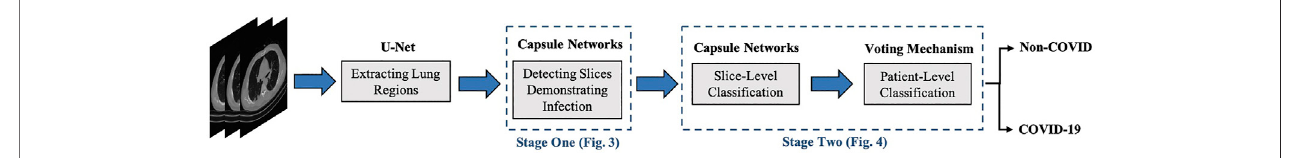
FIGURE 2 | The two-stage architecture of the proposed COVID-FACT.